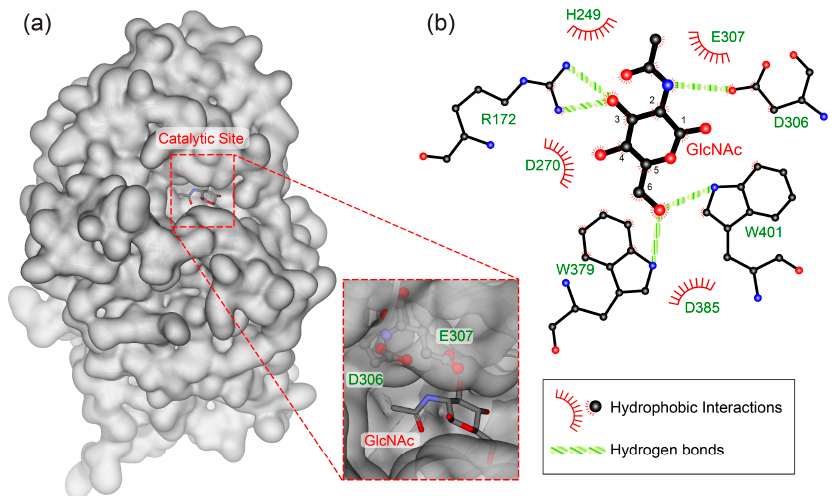
Figure 5. ( a ) Three-dimensional homology model of SnHex based on the structure of the highly homologous β - N -acetylhexosaminidase from Streptomyces plicatus complexed with GlcNAc (PDB code 1M01) with the amino acids D306 and E307 located at the catalytic site. ( b ) Two-dimensional illustration of the substrate-ligand interactions in the active site of